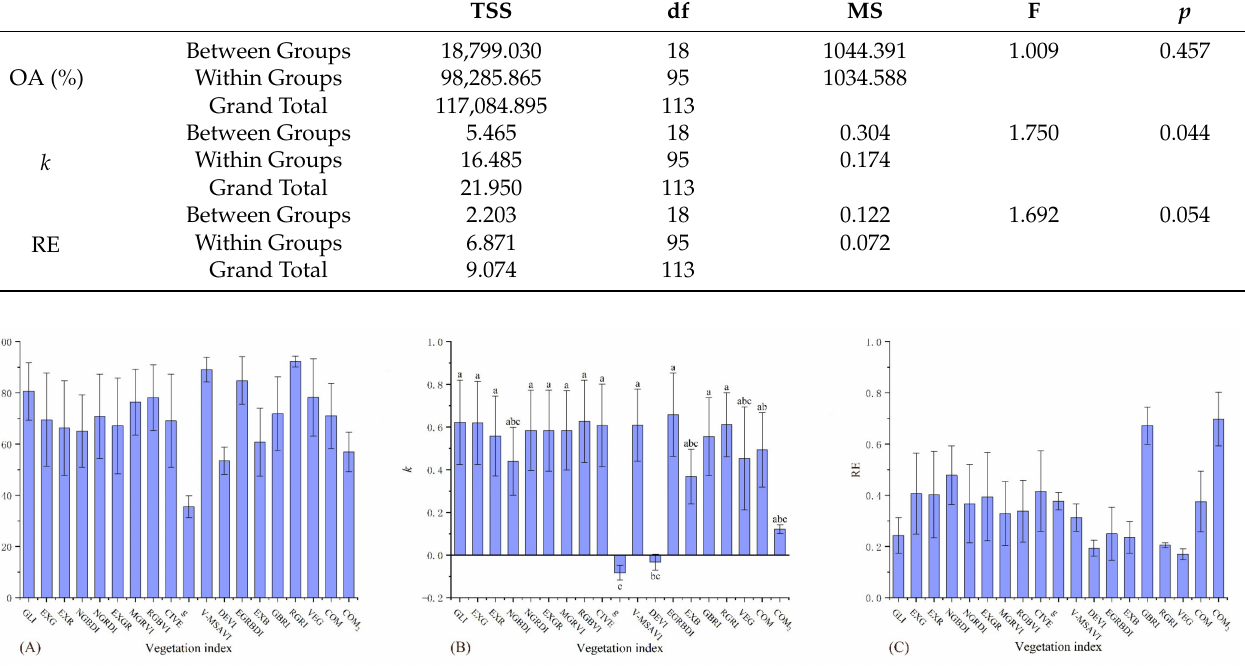
Figure 6. OA, k , and RE differences of 19 vegetation indices on the non-desertification grade. ( A ) fig- ure is the result of one-way analysis of variance for OA. ( B ) figure is the result of one-way analysis of variance for k . ( C ) figure is the result of one-way analysis of variance for RE. Values with the same lowercase letters within vegetation indices are not significantly different at p <